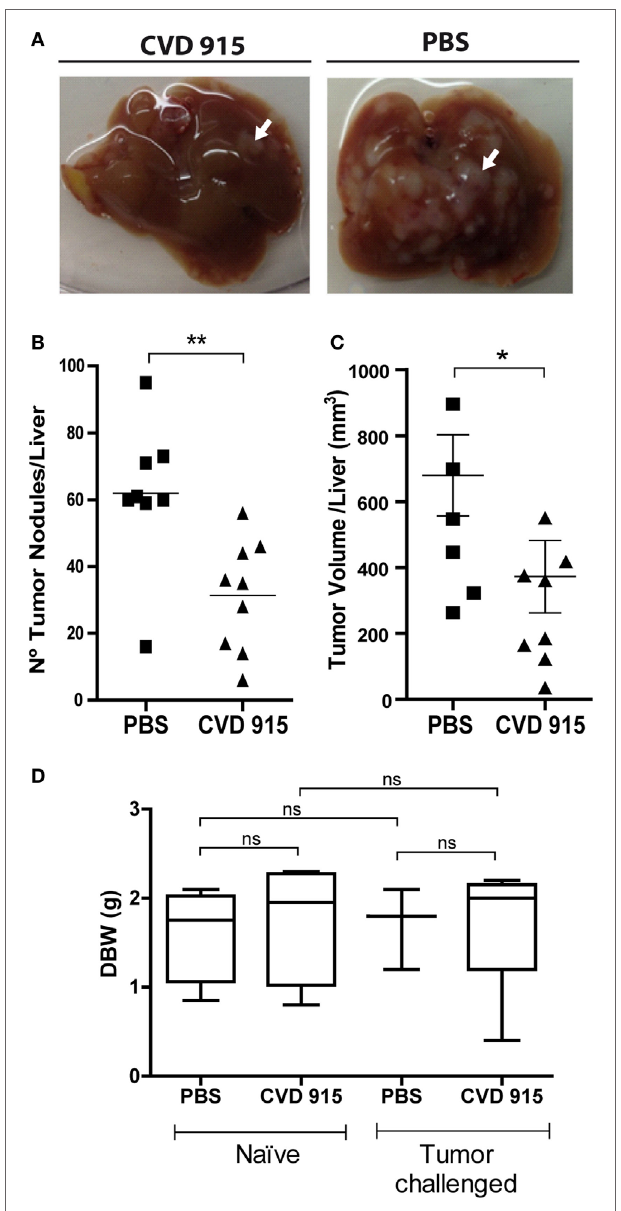
FigUre 2 | anti-metastatic effects of the oral Salmonella vaccine cVD 915 . Twenty-one days after treatment with CVD 915 or PBS, livers from tumor-bearing mice were removed. (a) Representative images of one liver from each group are shown. Arrows indicate a representative tumor nodule (B) Number of superficial tumor nodules per liver. (c) Liver tumor volumes. (B,c) Dots represent the tumor number or volume of each mouse. * p < 0.05, ** p < 0.01 ( n = 8–9). Data are from two experiments representative of four. (D) Body weight gain of naive and tumor-challenged mice. Mice were weighed before (day 0) and 21 days after treatment. Box and whiskers represent the differential body weight (DBW) of each group. ns, not statistically significant ( n = 3–5). Data are from one experiment representative of